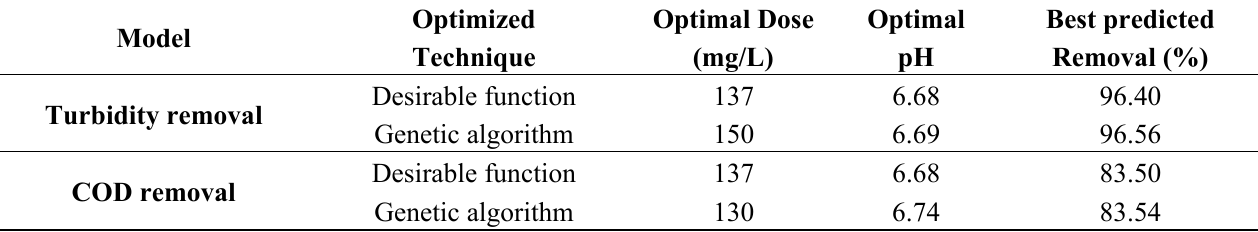
Table 5. Comparison between the desirable function and GA optimization techniques for optimum variables and predication for pollutants